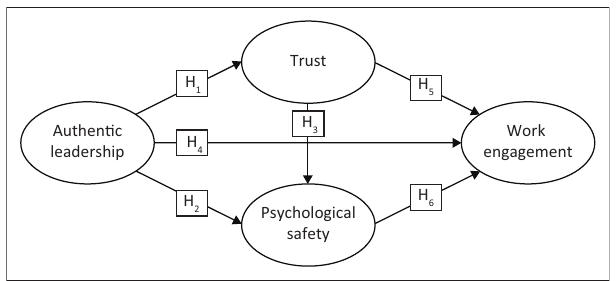
FIGURE 1: The hypothesised